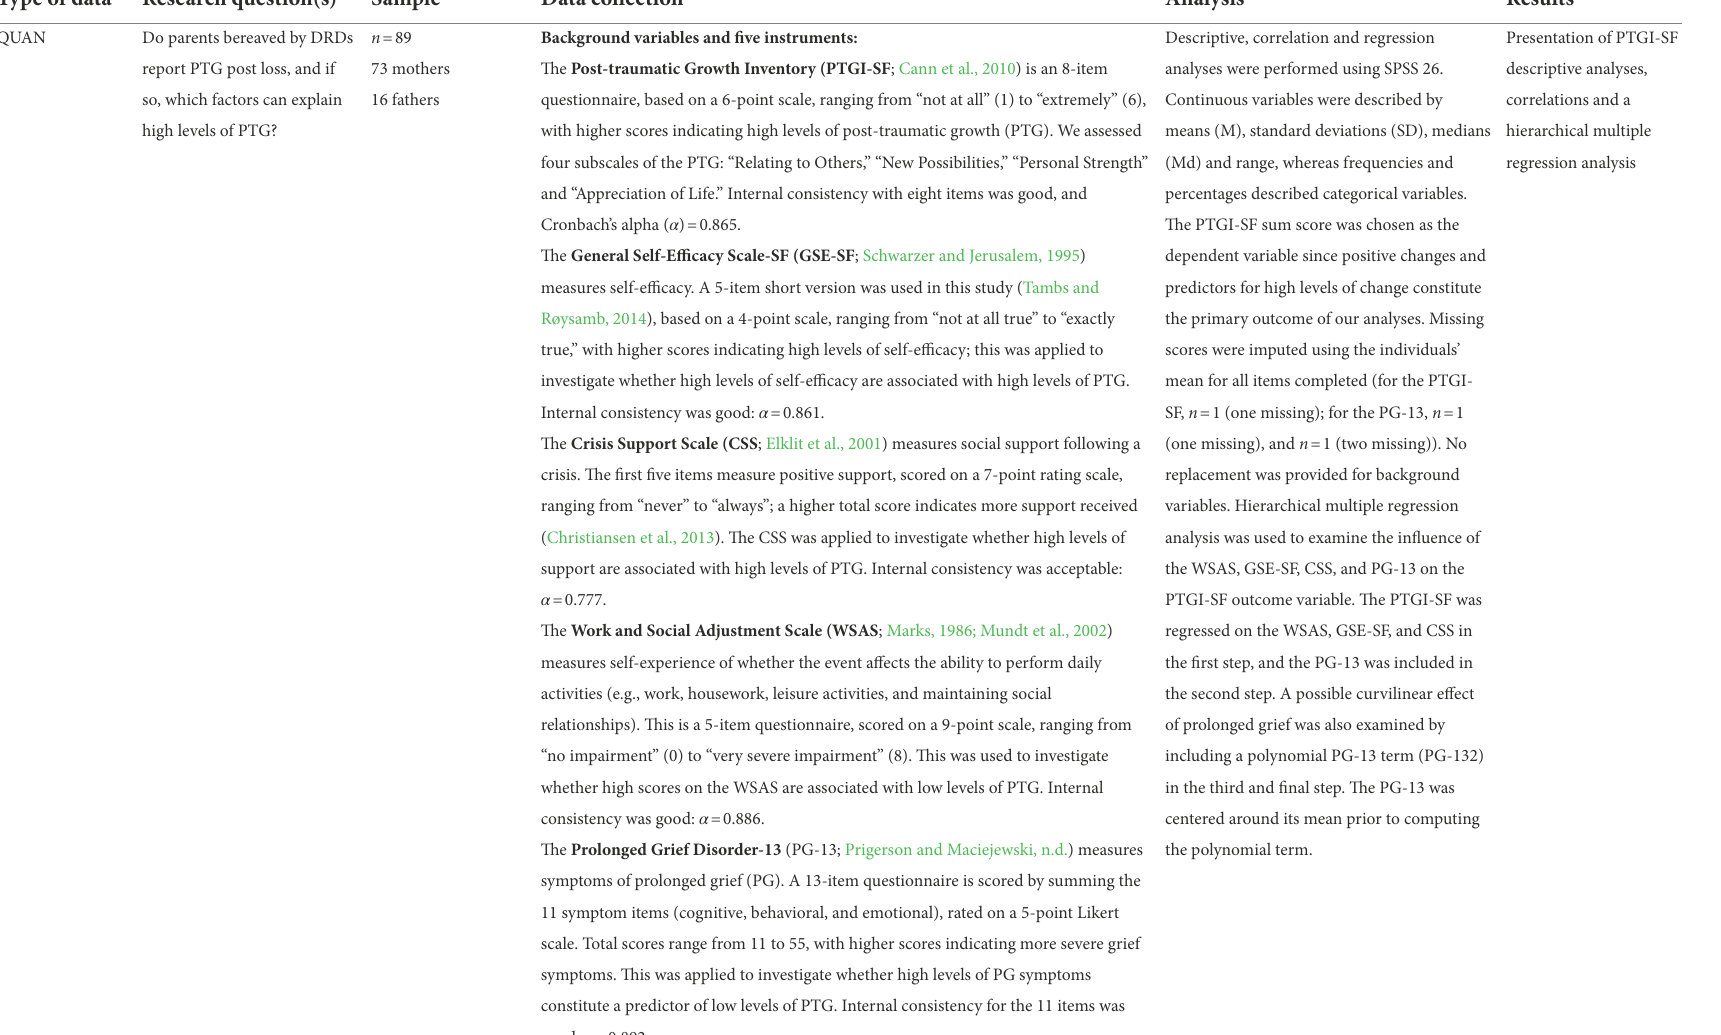
TABLE 2 Overview of the